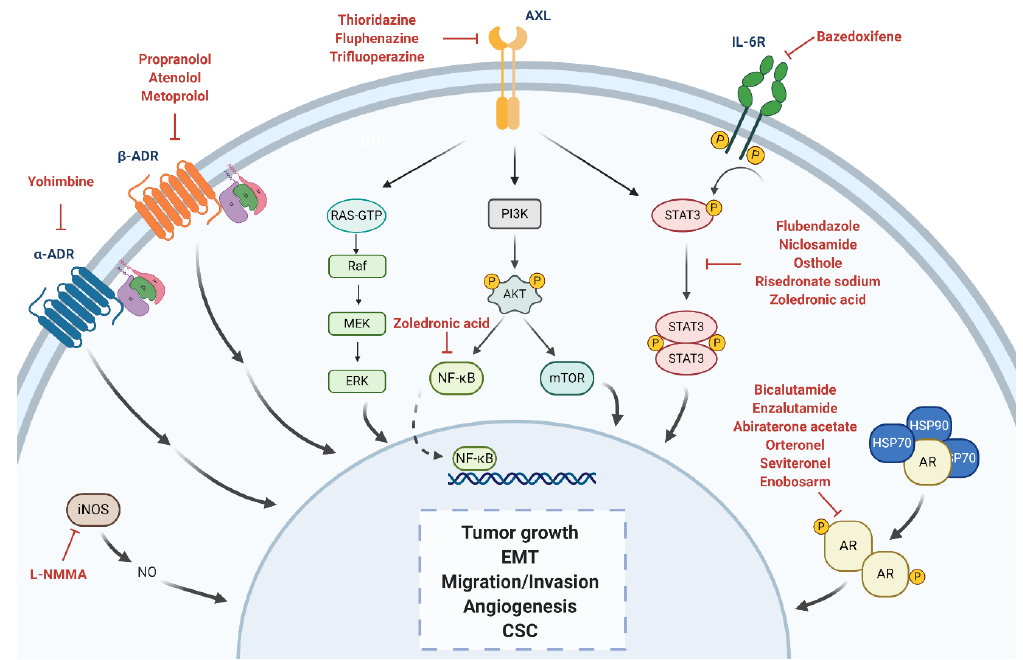
Figure 3. Overview of the different pathways investigated by drug repurposing. Repurposed inhibitors under investigation are shown in red. Created with BioRender.com.